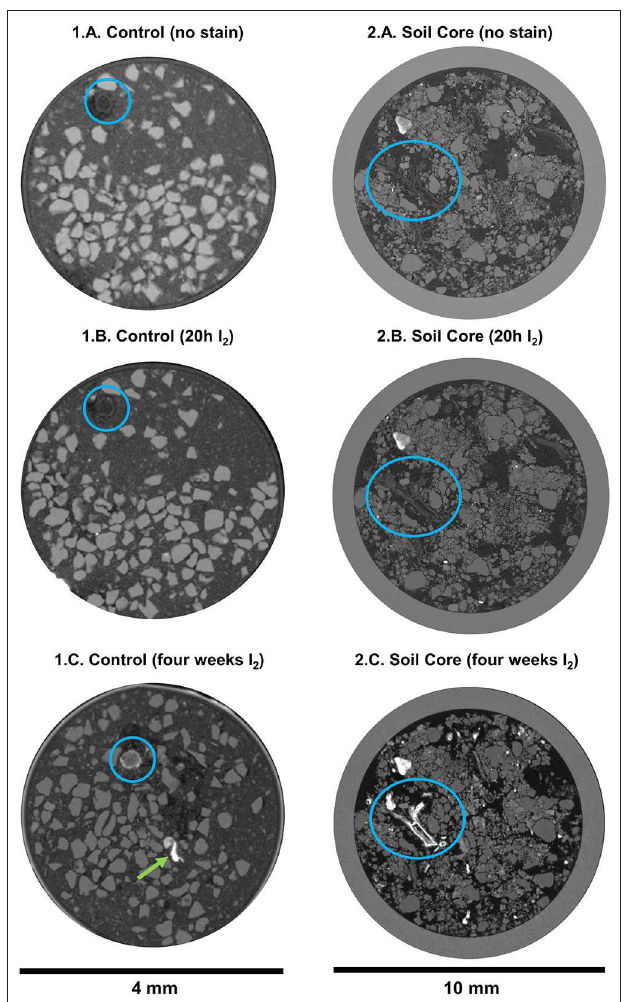
FIGURE 4 | Reconstruction images (X-Y plane) of the conventional X-ray tomographies ( µ CT, 50 kV, 7 µ m voxel resolution) of soil samples with follow treatments: (A) without staining, (B) after few hours I 2 staining (20h for small tubes and 40h for cores) and (C) after additional 4 weeks I 2 staining. (1) clay/sand mix control with a root fragment and Collembola inside; (2) soil core of 8mm (and 1mm circular glass container).